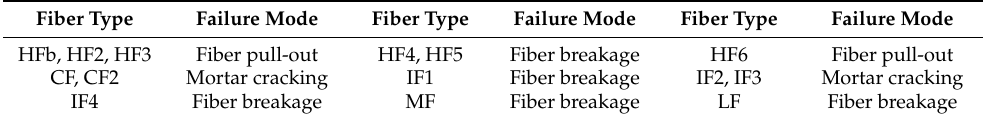
Table 4. Failure modes of different deformed steel